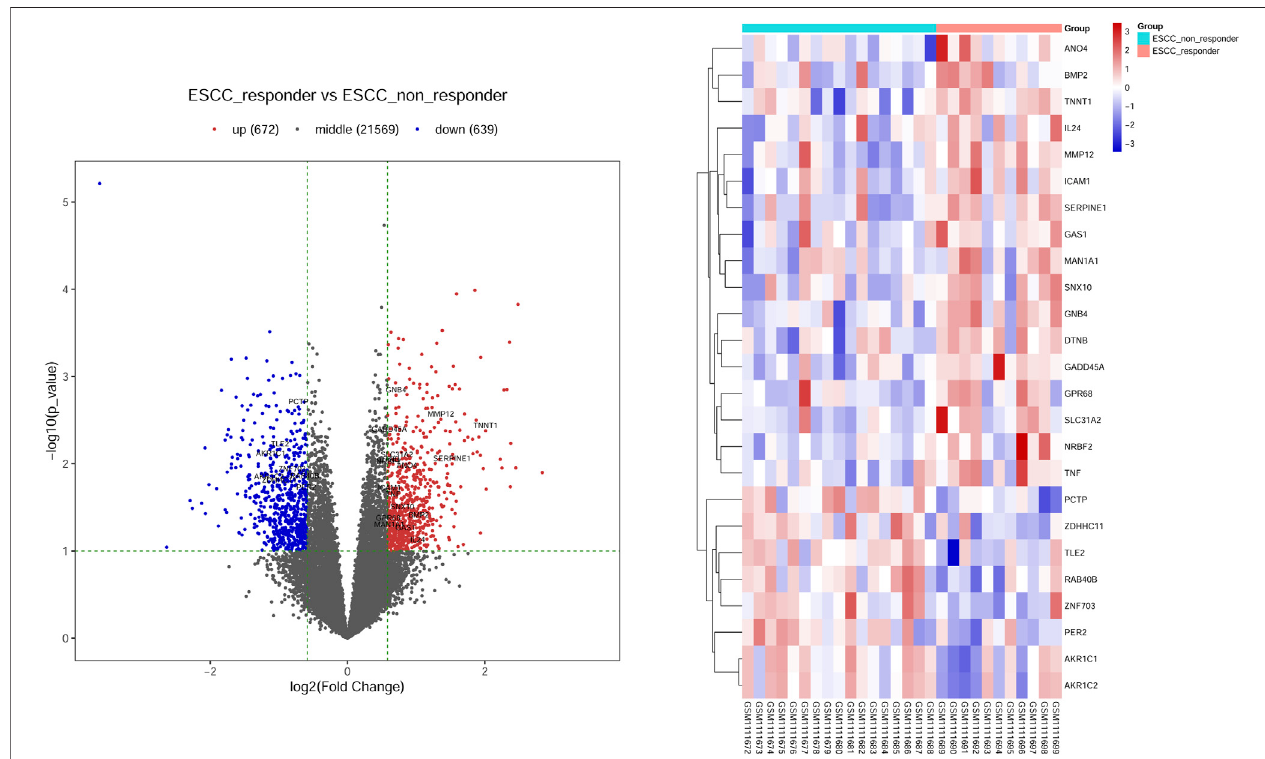
FIGURE2 | Screening the differential expression genes (DEGs) in ESCC-nCRT responder and non-responder samples. (A) Volcano plot visualized the distribution of DEGs. Red dots represented up-regulated genes and blue dots were down-regulated genes. The overlapped genes were named in fi gures represented the up- regulated or down-regulated genes in both datasets. (B) Bidirectional clustering analysis of DEG in nCRT responder and non-responder samples. These genes are overlapped genes dysregulated in both datasets. The color changed from blue to red represented the expression level from low to high.